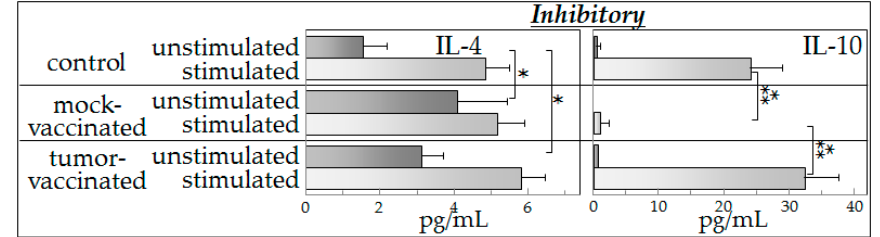
Figure 3. Vaccination of glioma-bearing mice restores an inhibitory cytokine profile that resembles that of control mice and stimulates production of the inhibitory cytokines in response to the presence of tumor-conditioned medium. Spleen cells from control mice and from vaccinated or mock-vaccinated glioma-bearing mice were cultured either with control medium or with glioma-conditioned medium and their production of inhibitory cytokines IL-4 and IL-10 was measured. Data shown are means ± SEM, with spleen cell production of cytokines being measured in duplicate for each mouse individually. * p < 0.05, *** p < 0.001.